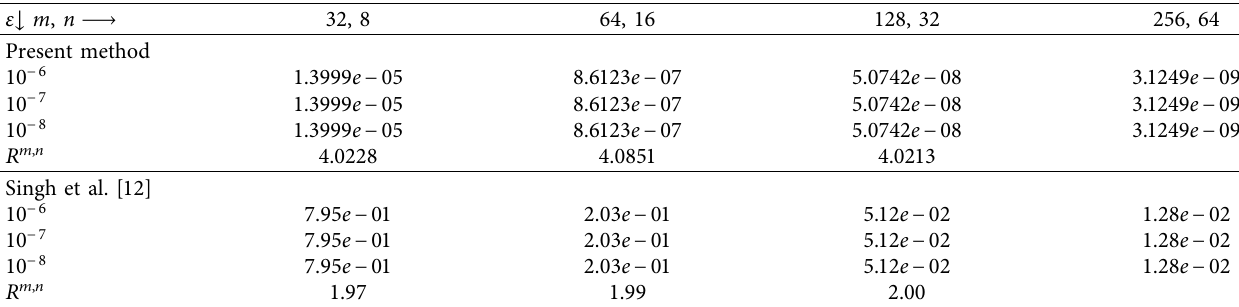
Table 3: Comparison of absolute maximum errors and rate of convergence R m,n for Example 1. ε ↓ m , n